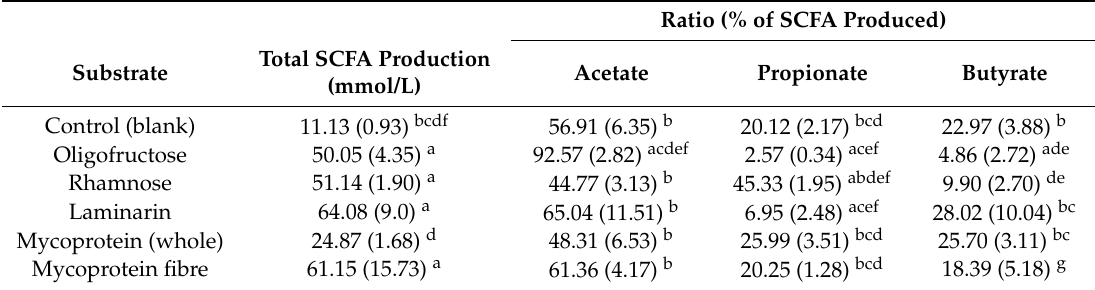
Table 1. Production of short chain fatty acid (SCFA) after 24 h batch